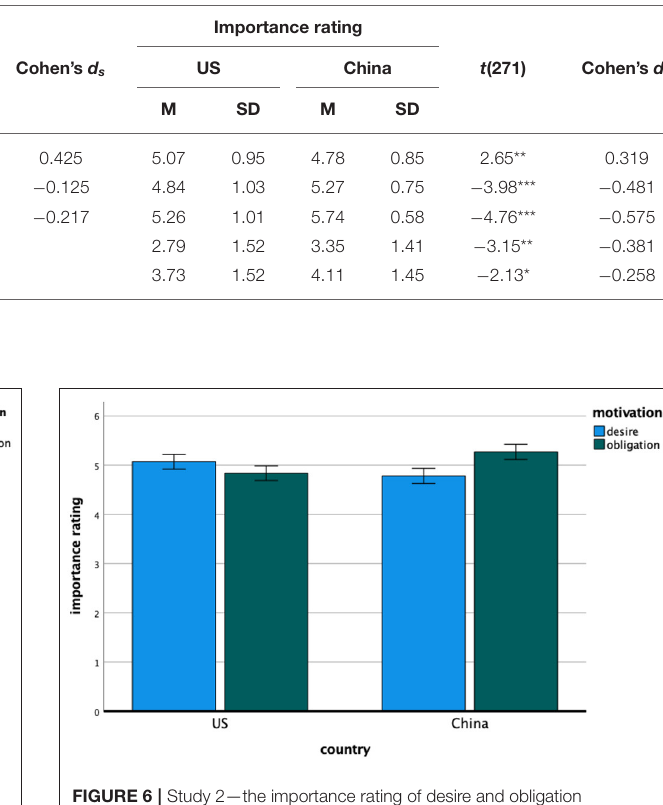
FIGURE 5 | Study 2—the relative importance of desire and obligation motivation for the self for American and Chinese participants. Error bars denote 95% confidence intervals of the mean.